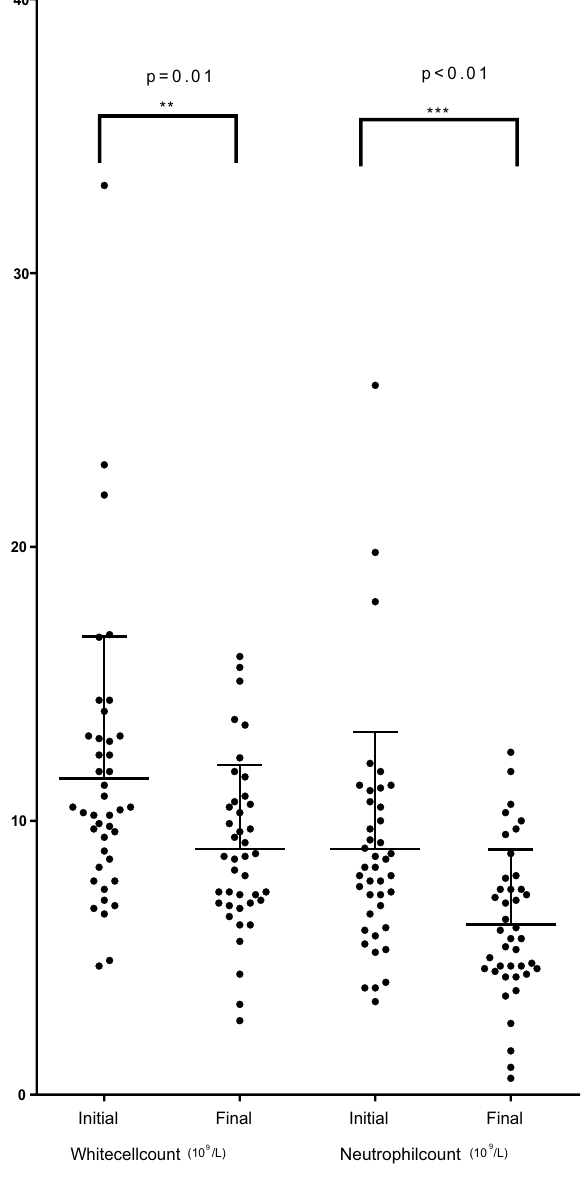
Figure 2. Initial and final total WBC and neutrophil counts.